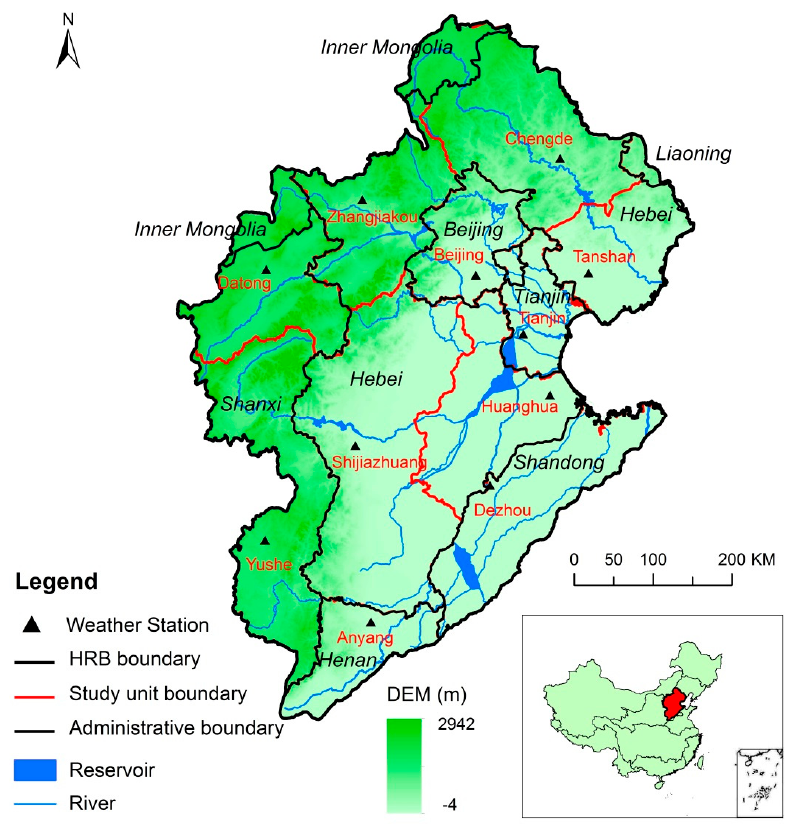
Figure 1. Locations of the study area and weather stations. Table 1. Division of the study area and corresponding weather stations.